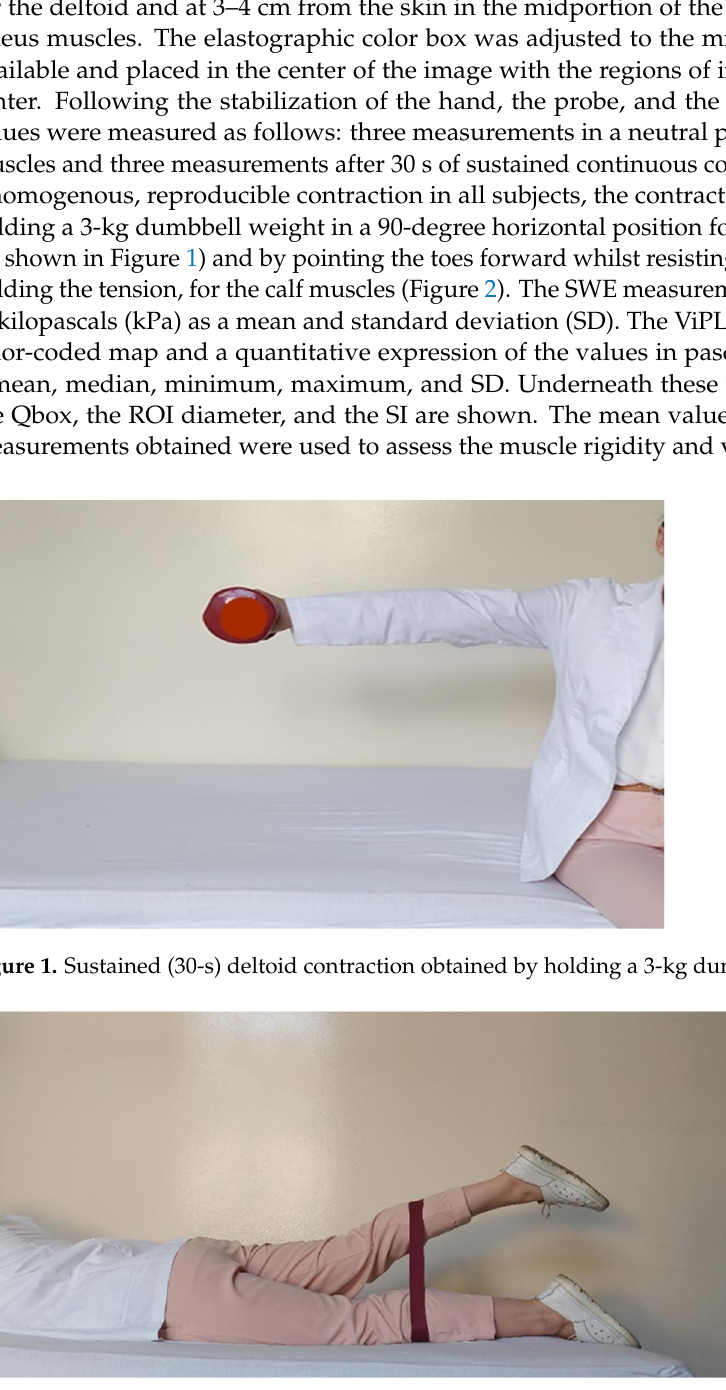
Figure 2. Sustained (30-s) calf muscle contraction obtained by pointing the toes forward, resisting the elastic band, and holding the tension.